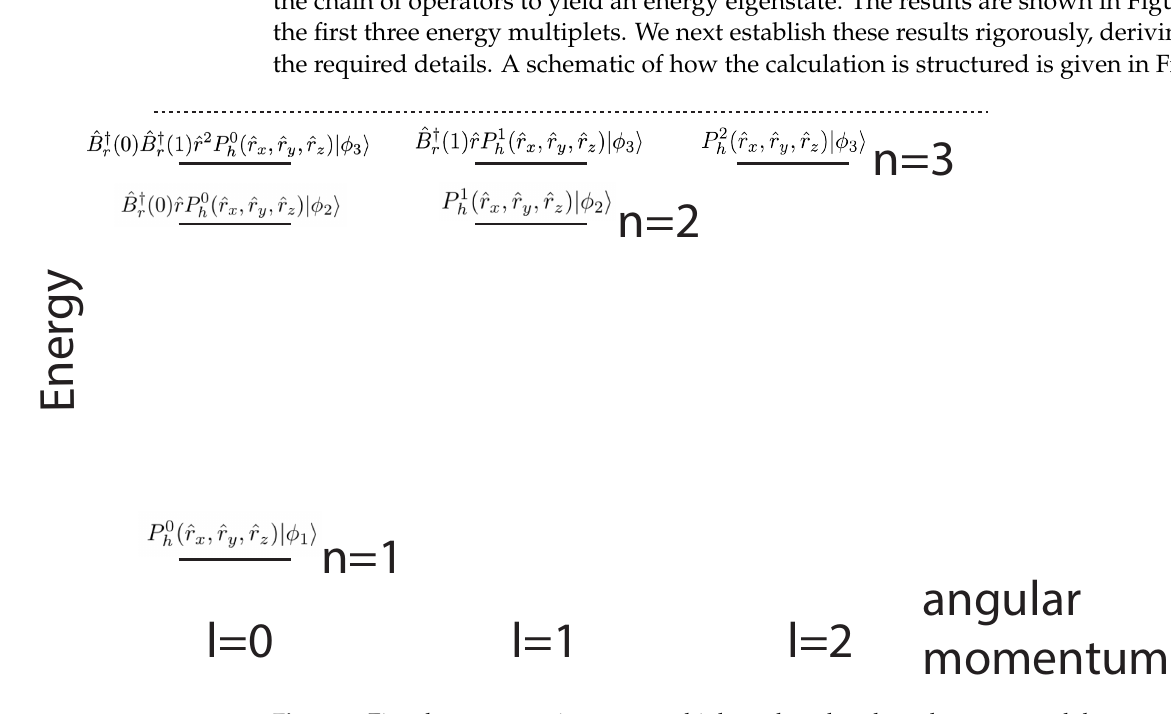
Figure 1. First three energy eigenstate multiplets, plotted to show the energy and the corresponding state, along with the angular momentum. The energies are the same for all inequivalent harmonic polynomials with the same l value. The dotted line is the limit point for the energy eigenvalues.